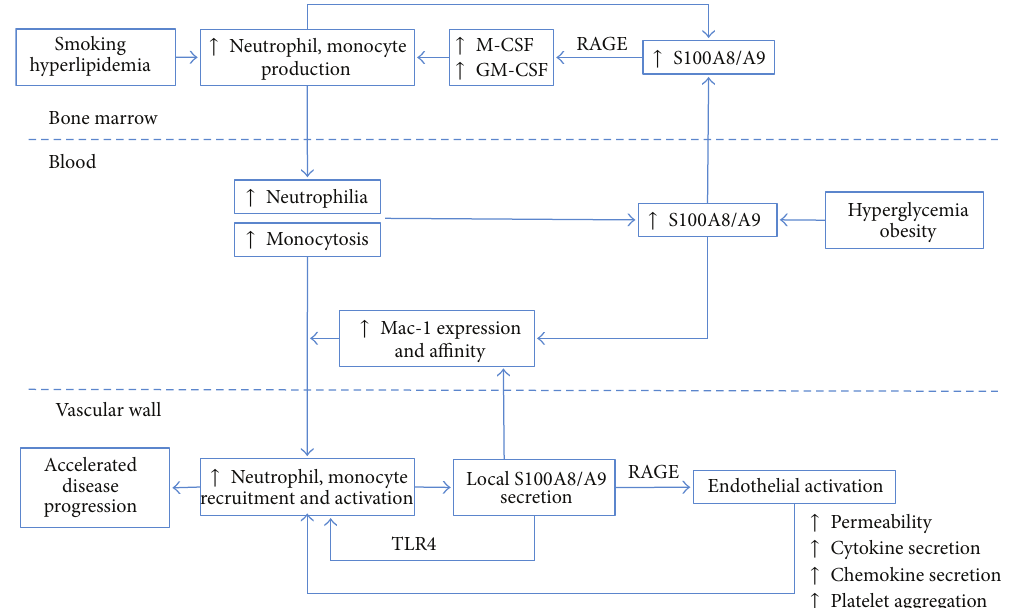
Figure 1: Overview of the interplay between S100A8/A9, traditional CV risk factors, circulating phagocytes, and atherogenesis. Smoking, hyperlipidemia, hyperglycemia, and obesity induce elevated S100A8/A9 production either directly or indirectly by stimulating neutrophilia and monocytosis. S100A8/A9 enhances phagocyte production in the bone marrow and facilitates their recruitment into the vascular wall through endothelial activation and increased Mac-1 expression and affinity. These effects are primarily mediated by RAGE and accelerated by hyperglycemia. In the vascular wall, S100A8/A9 binding to TLR4 triggers phagocyte activation and secretion of inflammatory cytokines, further contributing to phagocyte recruitment and accelerated atherogenesis. M-CSF: macrophage colony stimulating factor; GM-CSF: granulocyte-macrophage colony stimulating factor; RAGE: receptor for advanced glycation end products; TLR4: toll-like receptor 4.